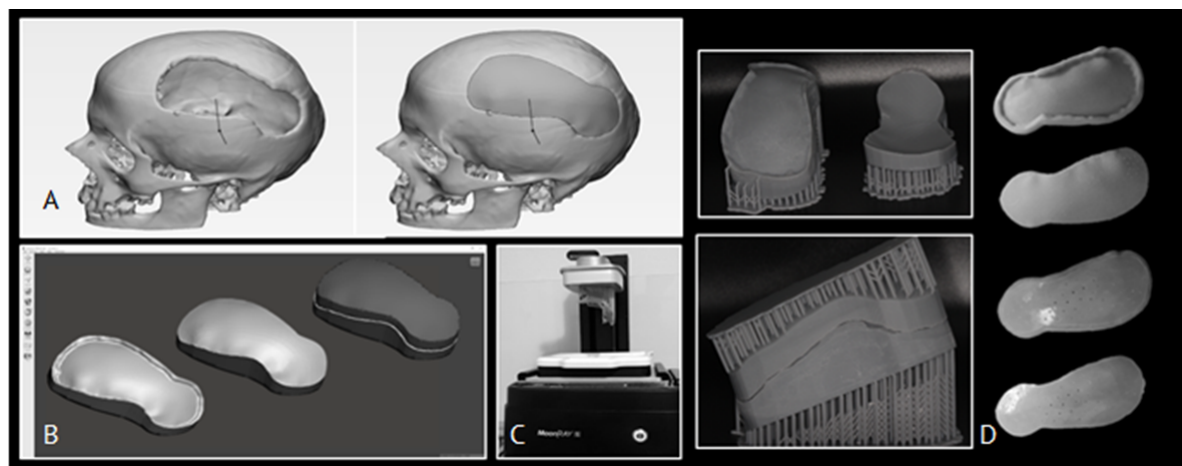
Figure 2 . A) Virtual surgical planning of the cranial defect. B) Modelling of patrix and matrix based on customized cranial plate within Meshmixer software. C) Printing of 3D matrix and patrix using the DLP Moonray S100 printer. D) The matrix, plate, application of PMMA and finishing the customized